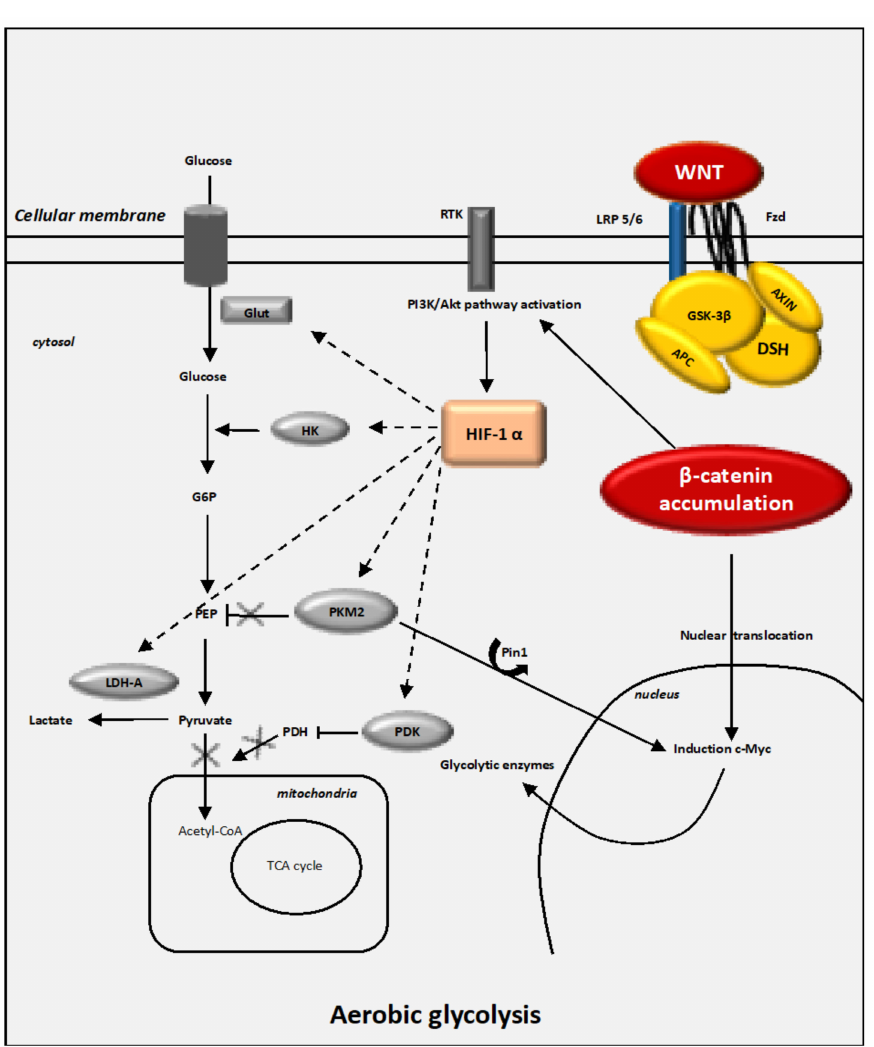
Figure 2. The WNT/ β -catenin pathway and the Warburg effect. WNT ligands bind with the Frizzled/LRP 5/6 receptor complex, leading to LRP phosphorylation of the AXIN/APC/GSK-3